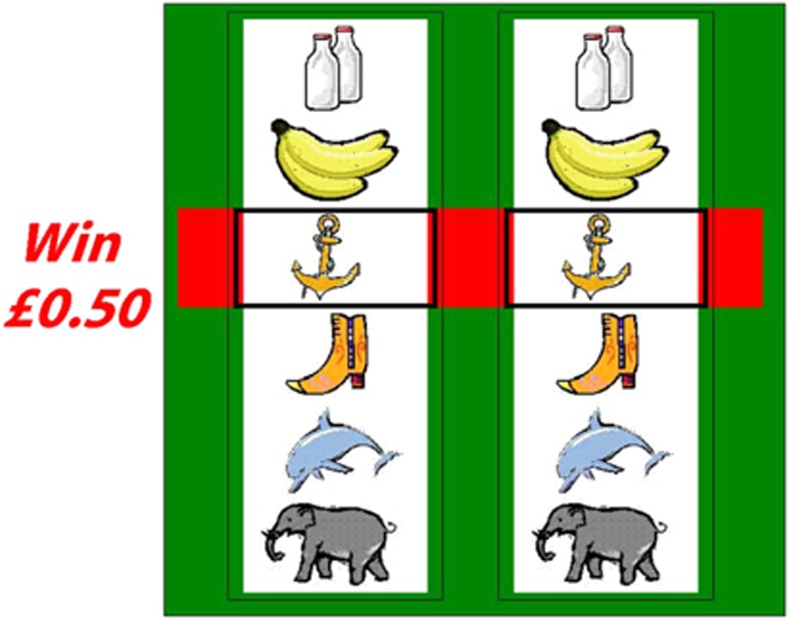
Example of a ‘win trial' in the fMRI simulated slot-machine game.